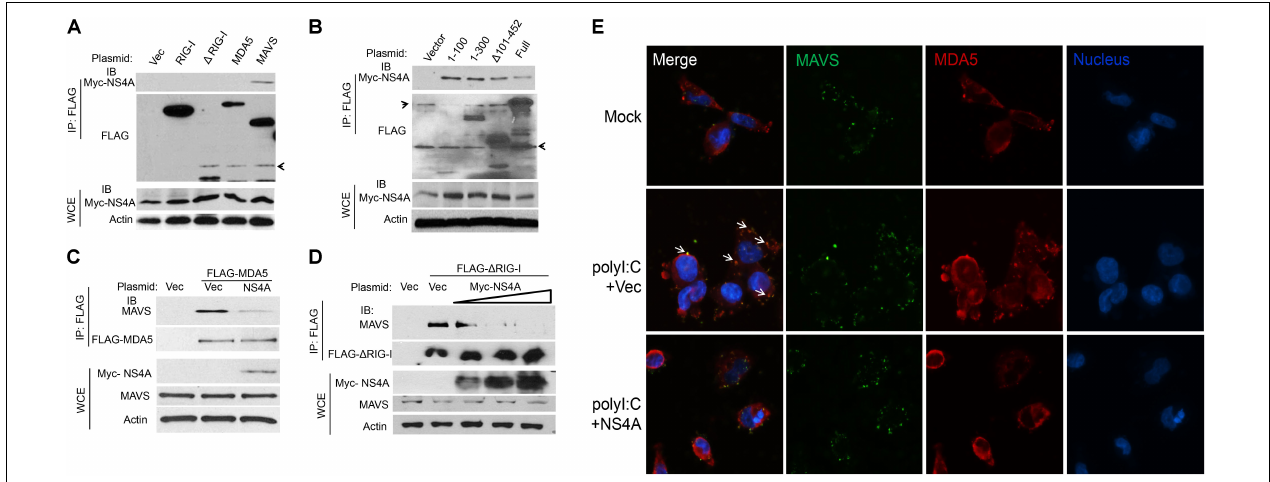
FIGURE 5 | NS4A interacts with MAVS and blocks RLR binding to MAVS. (A) Co-immunoprecipitation (co-IP) of MAVS with NS4A from HEK293T cells transfected with Myc-NS4A and the indicated FLAG-tagged genes using an anti-FLAG monoclonal antibody, followed by immunoblotting (IB). WCE, whole-cell extract. (B) co-IP of the truncated forms of MAVS with NS4A from HEK293T cells transfected with Myc-NS4A and FLAG-tagged MAVS mutants using an anti-FLAG monoclonal antibody. co-IP of (C) FLAG-MDA5 or (D) FLAG- (cid:49) RIG-I with endogenous MAVS from HEK293T cells transfected with FLAG-MDA5 or FLAG- (cid:49) RIG-I and Myc vector or increasing amounts of Myc-NS4A. The plasmid DNA molar ratio of Myc- NS4A to FLAG-MDA5 is 1:3; to FLAG- (cid:49) RIG-I are 1:6, 1:3, and 1:2. (E) Immunofluorescent staining of endogenous MAVS and MDA5 in human trophoblasts. Trophoblasts were untreated (Mock) or transfected with either a FLAG vector or FLAG-NS4A for 24 h and then stimulated with 20 µ g/ml of heavy molecular weight polyI:C-H for 8 h. MDA5/MAVS was stained with a rabbit anti-MDA5 and mouse anti-MAVS antibody followed by secondary antibodies conjugated with Alexa Fluor 594/488. The nuclei were counter-stained with DAPI. The images were acquired using an inverted Nikon Eclipse Ti fluorescence microscope. The arrows indicate colocalizations of MDA5 and MAVS. In (A–C) actin is a housekeeping protein control. The arrow heads point to non-specific bands. The data shown are representative of three independent experiments.